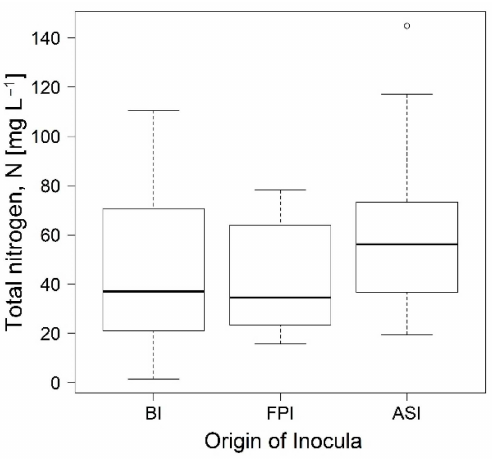
Figure 1. Total nitrogen found in the bioreactors inoculated from Activated Sludge (ASI), Biodisc (BI) and Facultative Pond (FPI). “ ◦ ” Boxplot outliers.